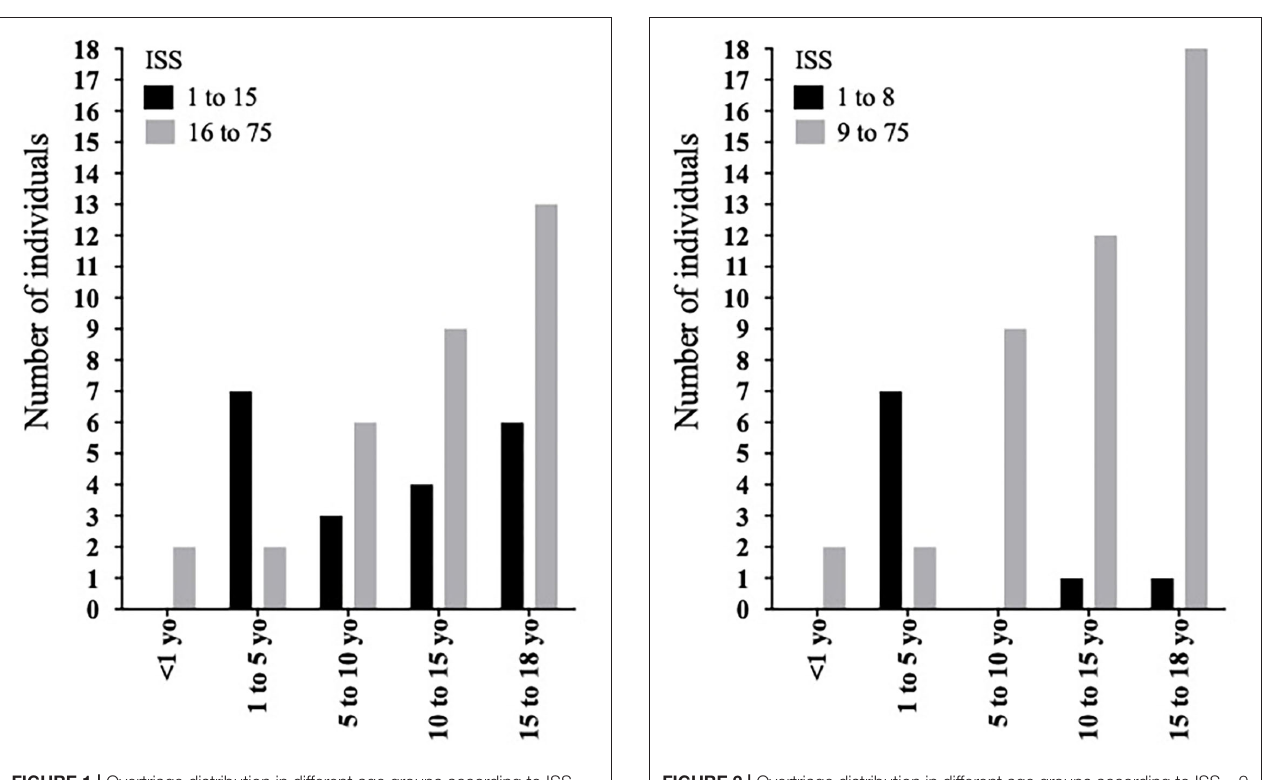
FIGURE 1 | Overtriage distribution in different age groups according to ISS < 16 as a cutoff.